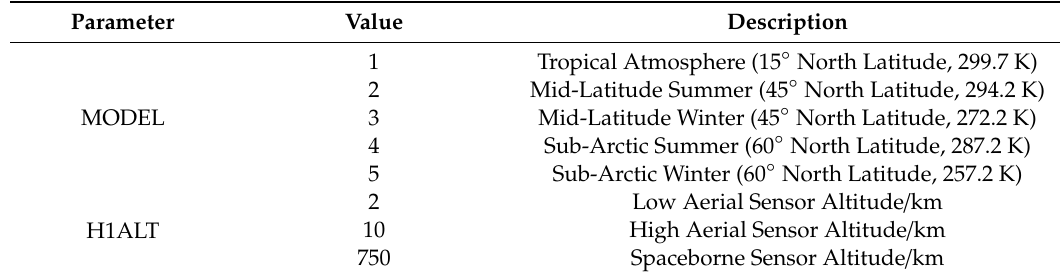
Table 1. Part of the input parameters of